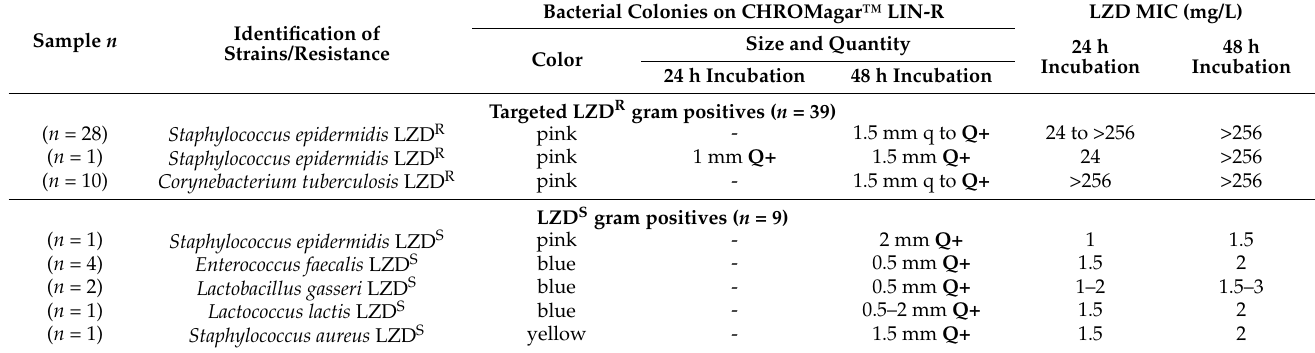
Table 2. Isolates cultured on CHROMagar TM LIN-R from the 358 nasal screening samples.